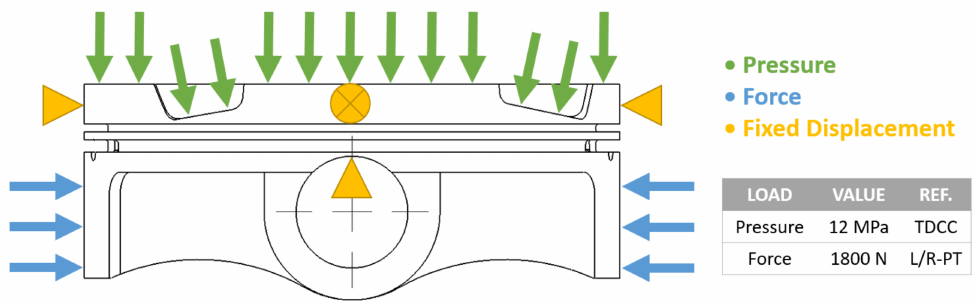
Figure 5. Load Case of the simplified Finite Element Model.